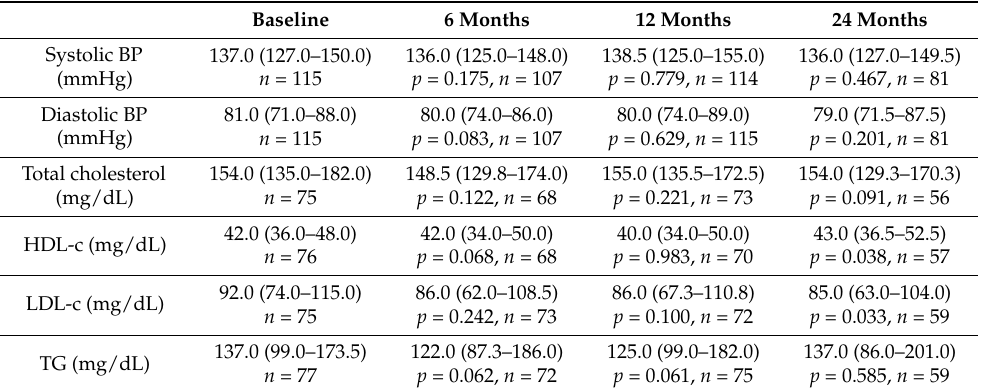
Table 4. Variation in cardiovascular risk indicators over time in patients who did not change their BP/lipid-lowering medications (median